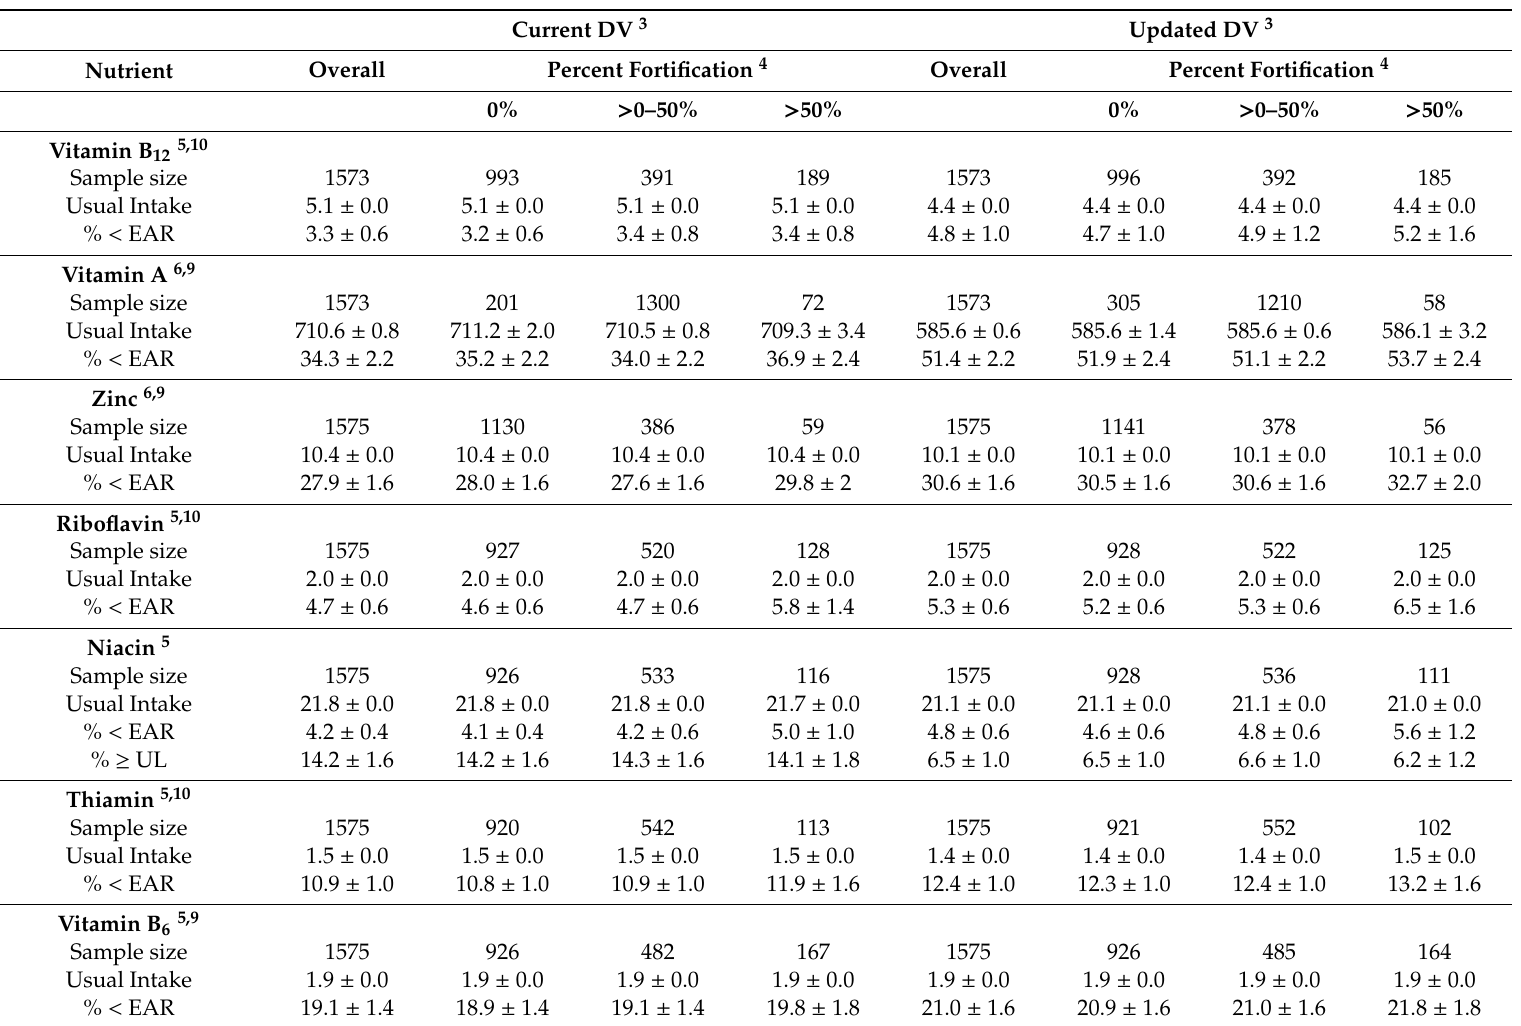
Table A5. Comparison of Current Daily Value (DV) and Updated DV nutrient intake models with overall and percent fortification subgroups for US adults ( > 70 years of age) (Mean ± SEM) 1,2